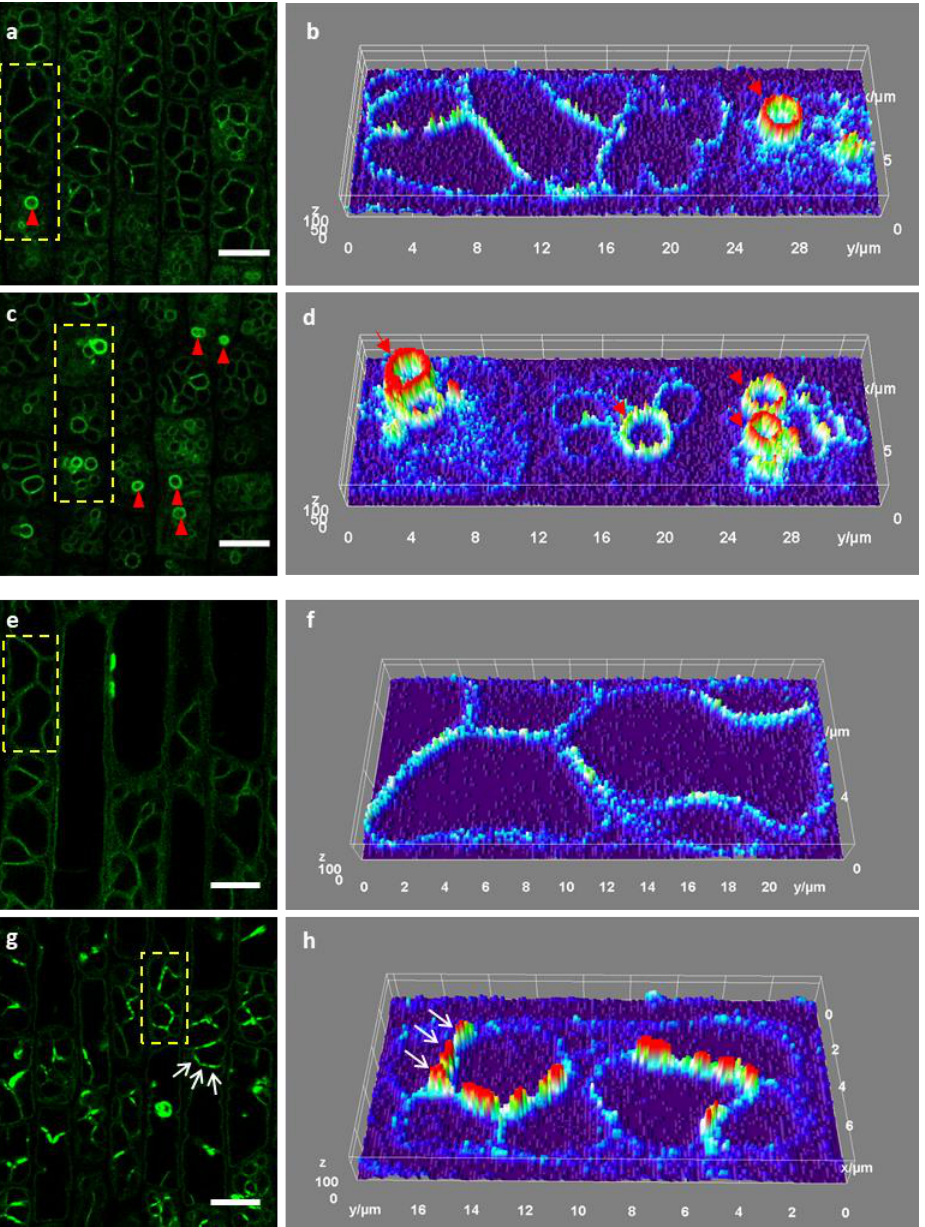
Figure 6. Vacuolar response to abiotic treatments in rice roots. ( a ) The vacuole morphology in control rice root cells of the transition zone. ( b ) 3D surface plot of signal intensity from the yellow, dashed rectangle in ( a ). ( c ) The vacuole morphology in rice root cells of the transition zone treated with 18% PEG (polyethylene glycol 4000) for 30 min. The red triangles (in a and c ) indicate bright bubble-like vacuoles and correspond to the red arrows (in b and d ). ( d ) 3D surface plot of signal intensity from the yellow, dashed rectangle in ( c ). ( e ) The vacuole morphology in control rice root cells of the elongation zone. ( f ) 3D surface plot of signal intensity from the yellow, dashed rectangle in ( e ). ( g ) The vacuole morphology in rice root cells of the elongation zone treated with 150 mM NaCl for 50 min. ( h ) 3D surface plot of signal intensity from the yellow, dashed rectangle in ( g ). The white arrows (in g and h ) indicate the vacuoles with non-uniform signal distribution. Scale bars: 10 µm.